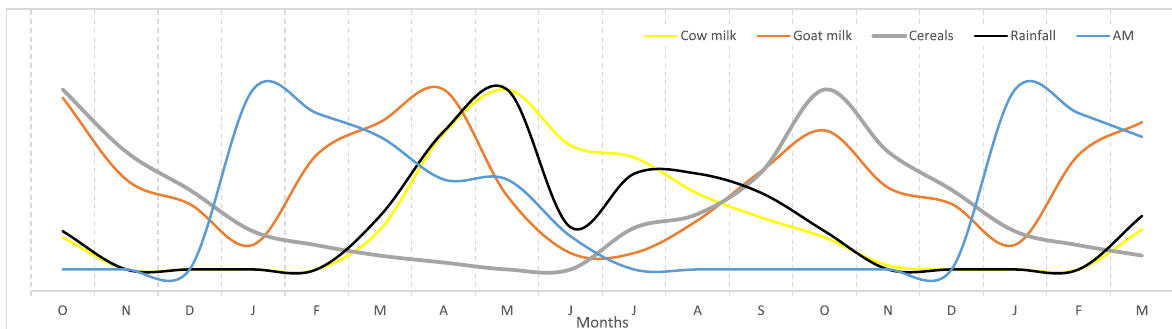
Fig. 1 Monthly pattern of food availability, rainfall and acute malnutrition in children. Note : The graph is derived from monthly calendars with 16 independent women’s groups and median scores; the monthly calendar method used a 12-month period; the graph shows an 18-month period to clarify the trends between December and January. AM, acute child malnutrition